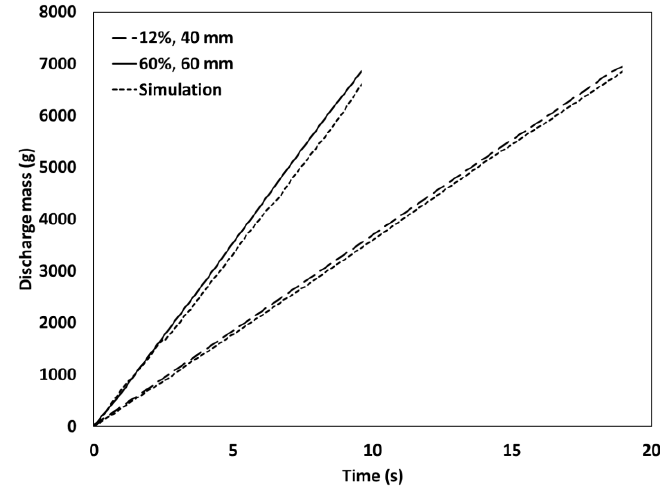
Figure 11. Mass profiles for soybeans with 12% and 60% moisture content at 40 and 60 mm orifice sizes, respectively, obtained by experiments and simulations during discharge.